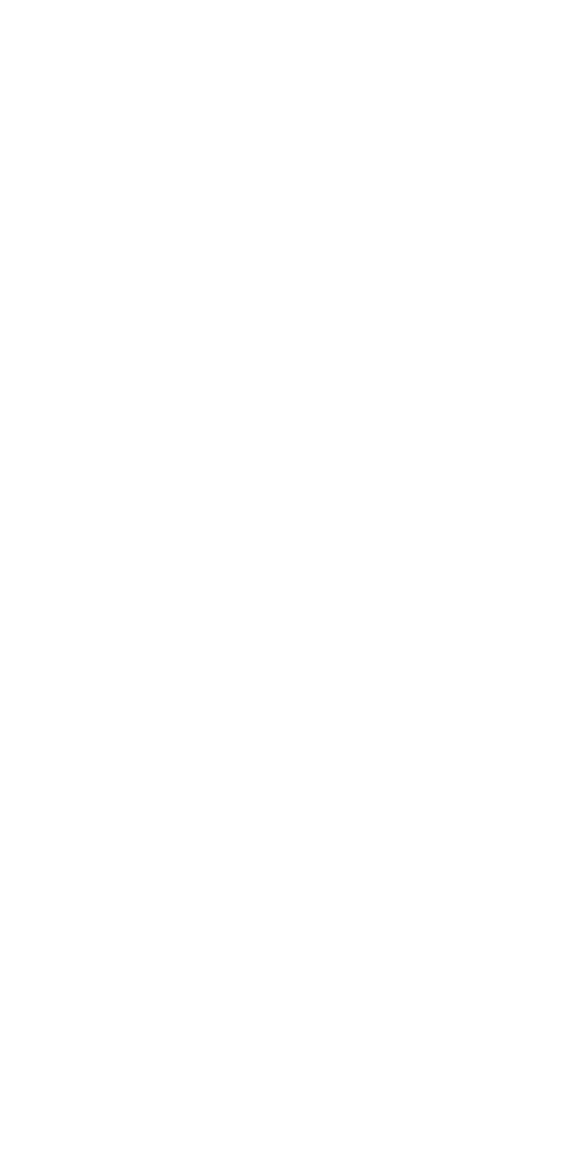
FIGUREA5 |Amino acid sequence conservation in selected residues that ligate FeMo-co (Cys-275, red box, and His-442, blue box) and that have been implicated as important in the FeMo-co binding pocket (indicated by a gray box). Representative NifD,VnfD, AnfD, and UncD (uncharacterized nitrogenase). Numbering is based on NifD from Azotobacter vinelandii AvOP. Abbreviations: A.v., Azotobacter vinelandii AvOP; M.a., Methanosarcina acetivorans str. C2A; M.m., Methanococcus maripaludis strain S2; R.c., Roseiflexus sp. RS-1; M.c. Methanocaldococcus sp. FS406-22.The conservation in the active site environment and active site custer ligands between classes of nitrogenase suggest that once the active site cavity evolved, it was maintained through